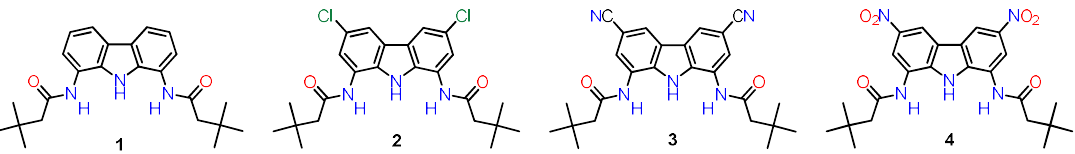
Figure 1. Model receptors investigated in this study.